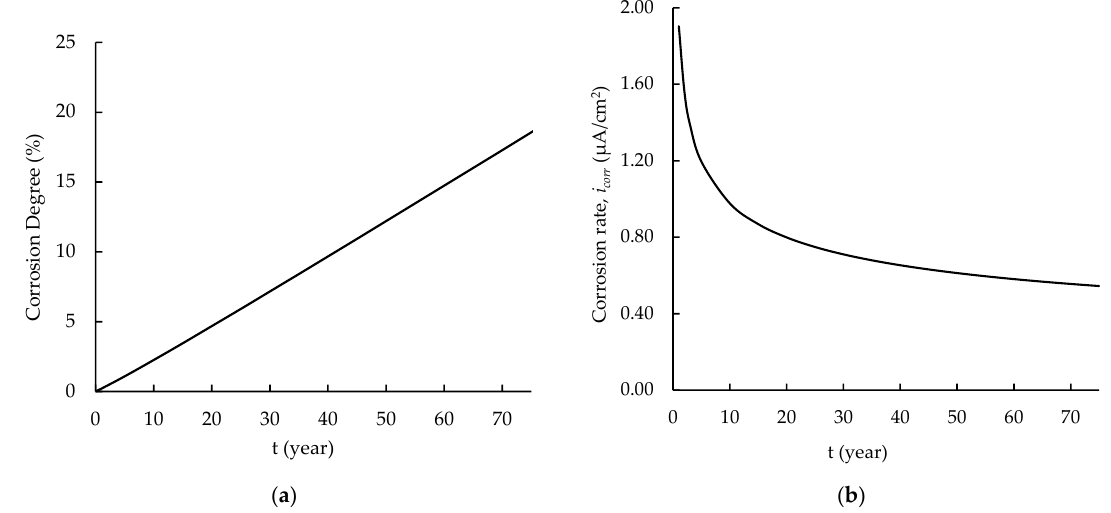
Figure 7. Time-dependent corrosion parameter. ( a ) Corrosion degree. ( b ) Corrosion rate. Figure 8 shows volumetric strain expansion in the model representing the 75-year rust expansion. The maximum strain expansions of the PC-bar and transverse rebar in the 75 years were 1.1448 mm and 1.6061 mm,